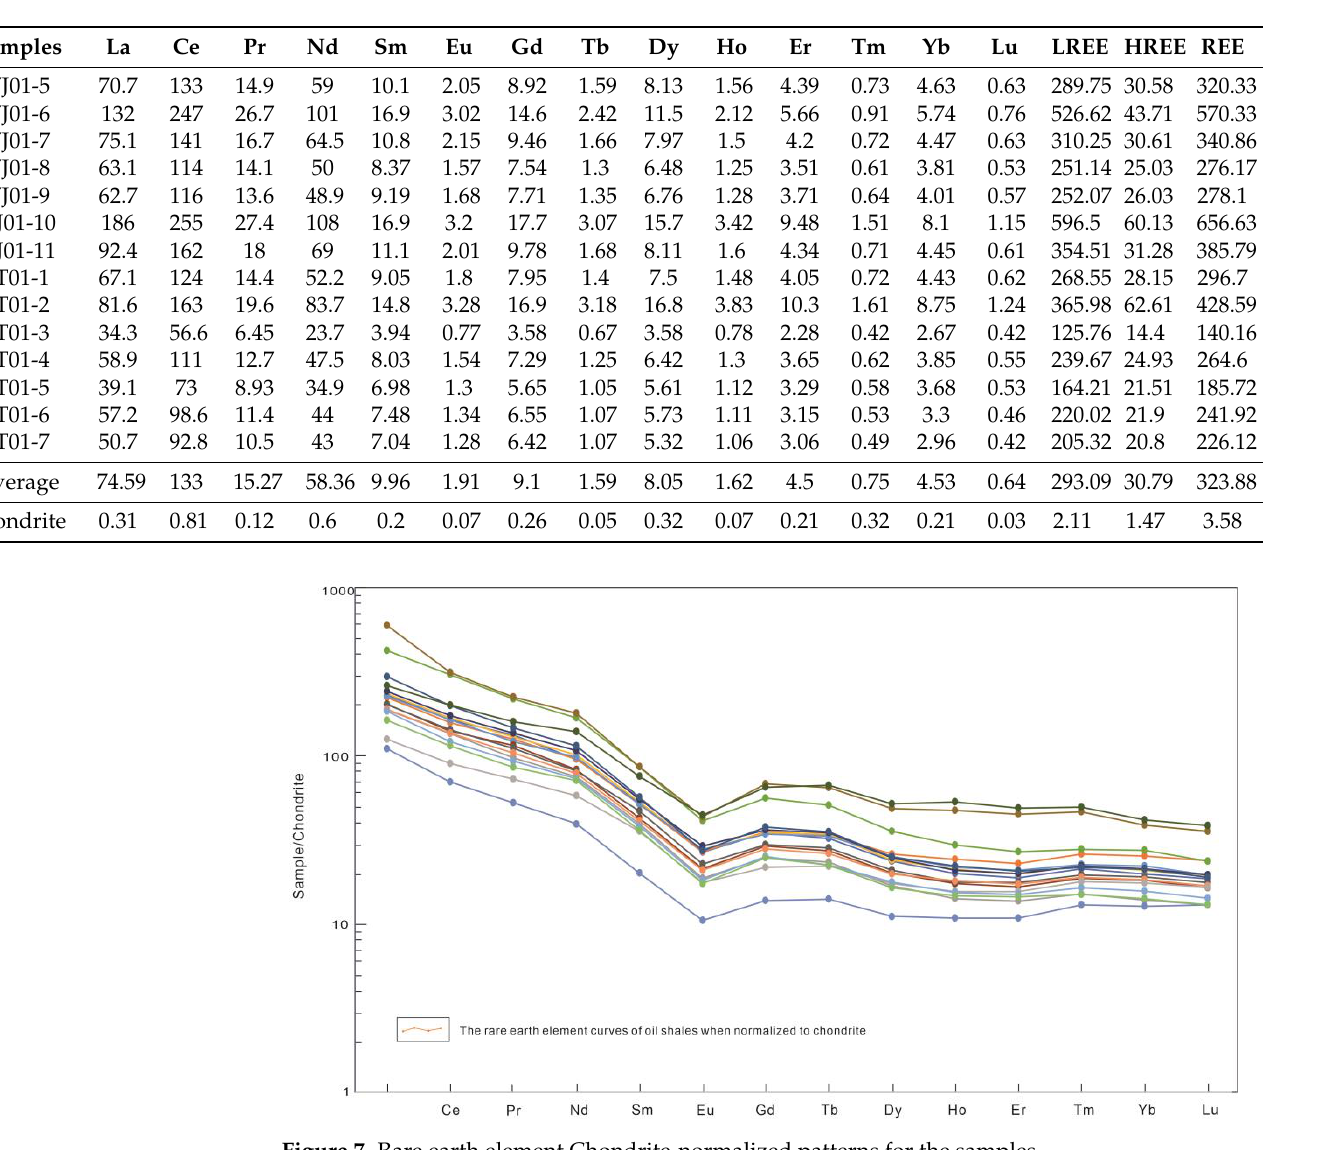
Figure 7. Rare earth element Chondrite-normalized patterns for the samples. Table 4. Rare earth elements (μg/g) in oil shale of Youganwo Formation in Maoming Basin.